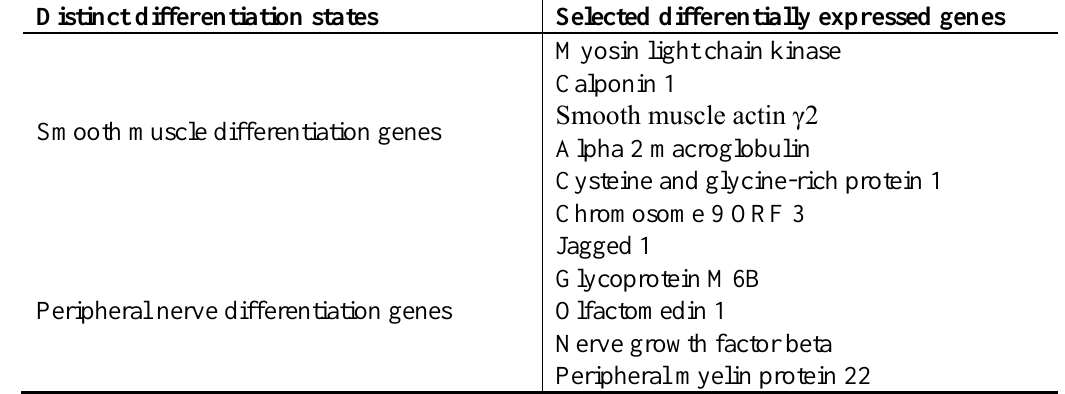
Table 3. Distinct expression patterns of the first step of the Harvard Study, a 138-gene